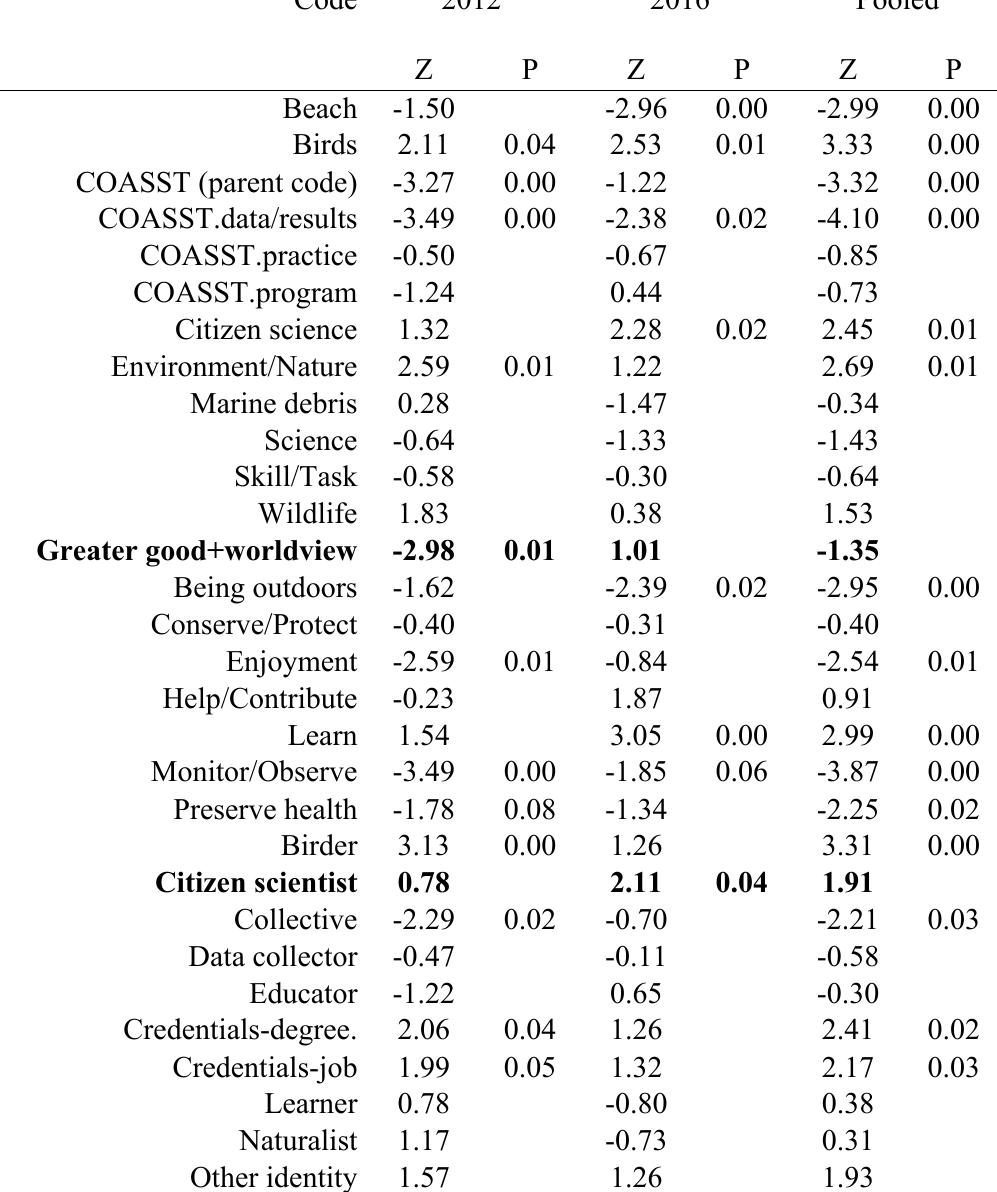
Table A3.1. Results of Z-tests determining differences between new and seasoned participant motivations (object of interest, action of interest, sense of self) within year (2012, 2016) and within the pooled dataset. Codes where the pooled dataset comparison was not significant whereas either year-specific comparison was significant are bolded. Note that codes with less than 3% (object, action) or 1% (senses of self) occurrence within all answering populations are included (i.e. the complete